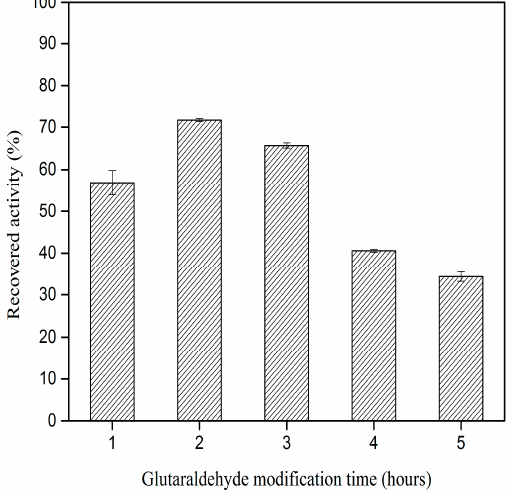
Figure 2. Effect of glutaraldehyde modification time on the recovered activity of CLEA–elastase. Glutaraldehyde with a concentration of 0.2% ( v/v ) was added to aliquots of aggregated free elastase prior to incubation at 4 ◦ C with rotating motion. CLEA–elastase was collected every hour for 5 h. The experiment was conducted in triplicate and recovered activities are presented as mean values ± standard